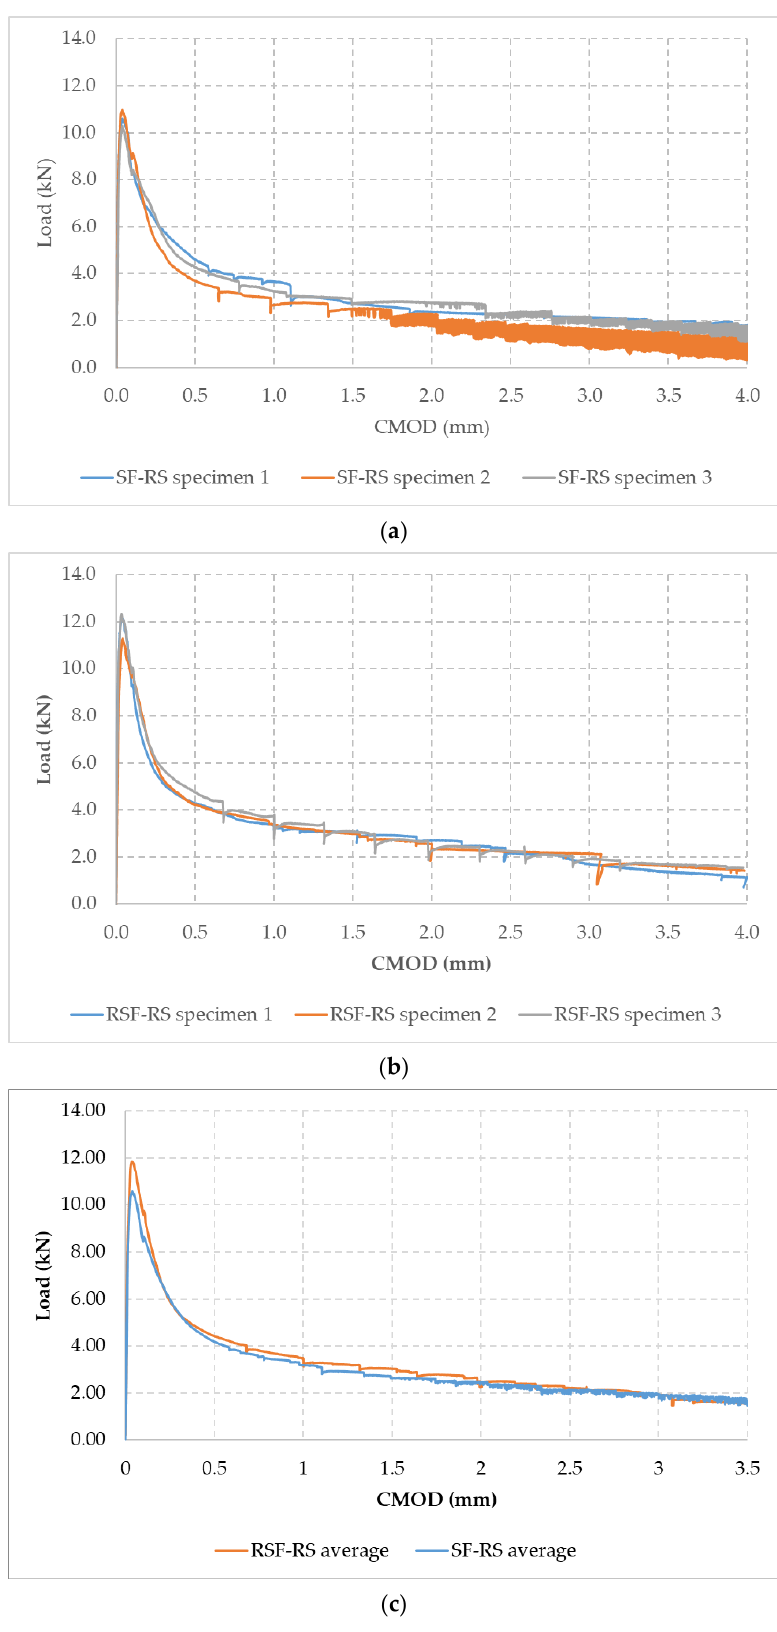
Figure 11. Load vs. CMOD curves according to EN 14651 [58] for determining flexural residual strength: SF-RS ( a ), RSF-RS ( b ), and average curves (mean of the three specimens per mix) for both mixes ( c